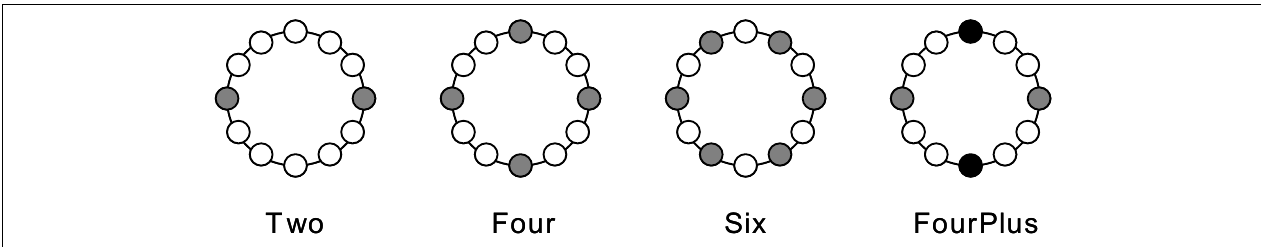
FIGURE 1 | Schematic overview of the tactor layout (top view) in the different conditions of Experiment 1. The tactors used are colored gray whereas the inactive tactors are white. In the FourPlus condition, only the gray tactors could be targets. The black tactors vibrated twice as often as the gray